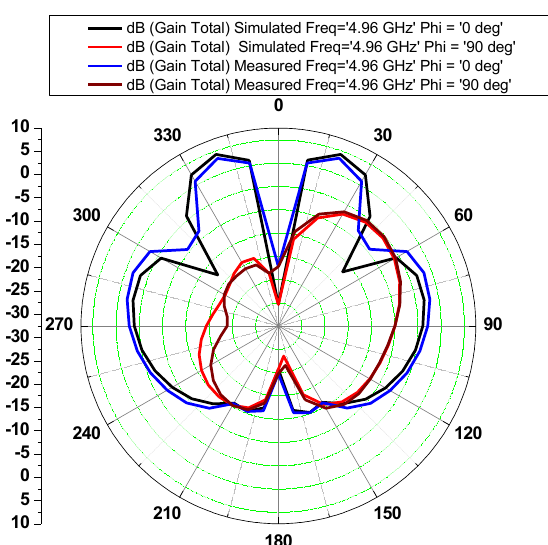
Figure 15: Anechoic chamber image of antenna